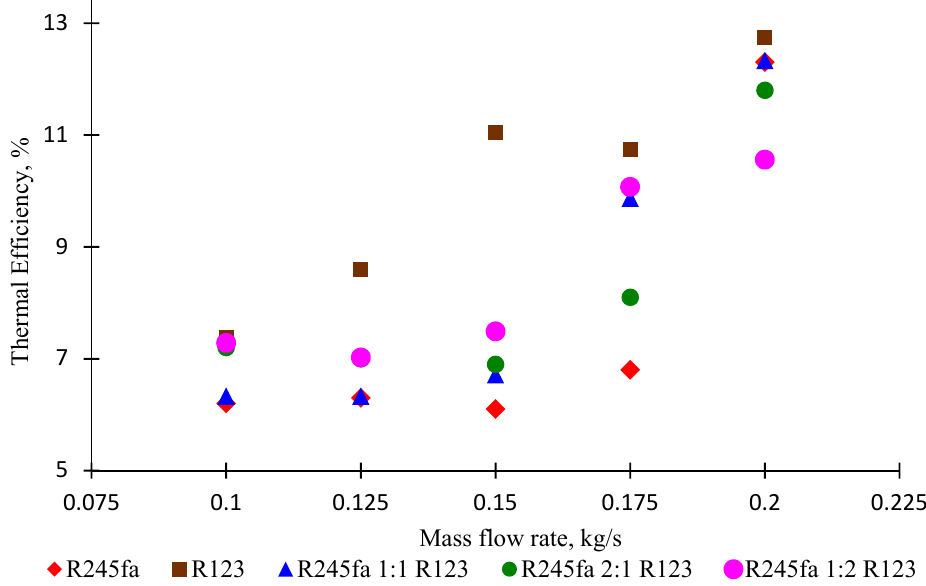
Figure 14. Efficiency ORC as a function mass flow rate for R245fa, R123, and mixed working fluids with heat source at 110 ° C.